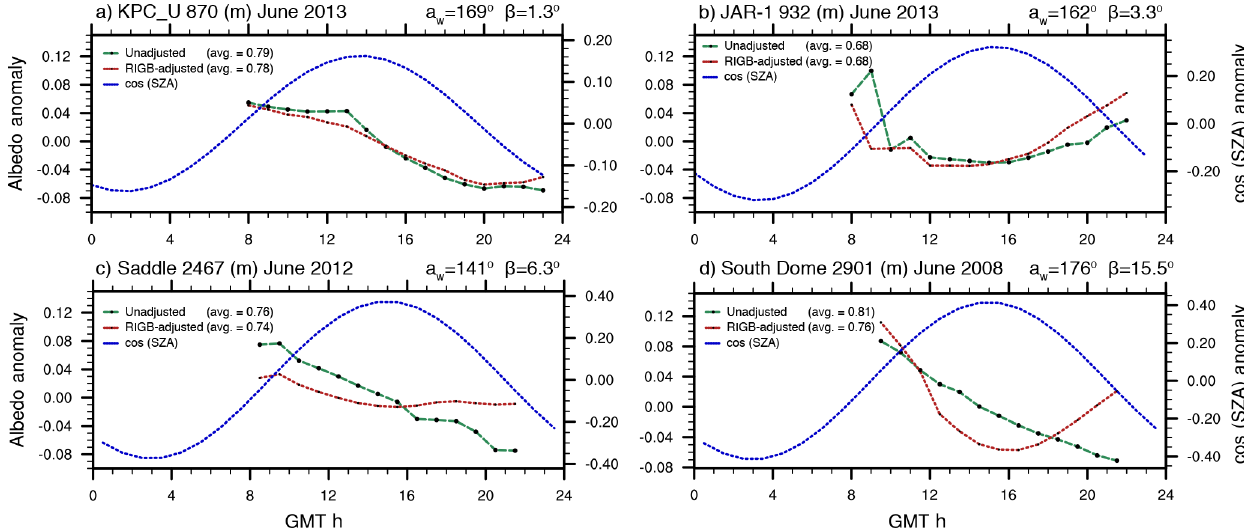
Figure 5. Diurnal variability of albedo at solar zenith angle less than 75 ◦ at (a) KPC_U; (b) JAR-1; (c) Saddle; (d) South Dome. The anomaly used here is the monthly average of hourly anomalies against daily averages. cos ( SZA ) represents the cosine of solar zenith angle. The station altitude, tilt angle and tilt direction, and data time period are labeled on the top of each panel.